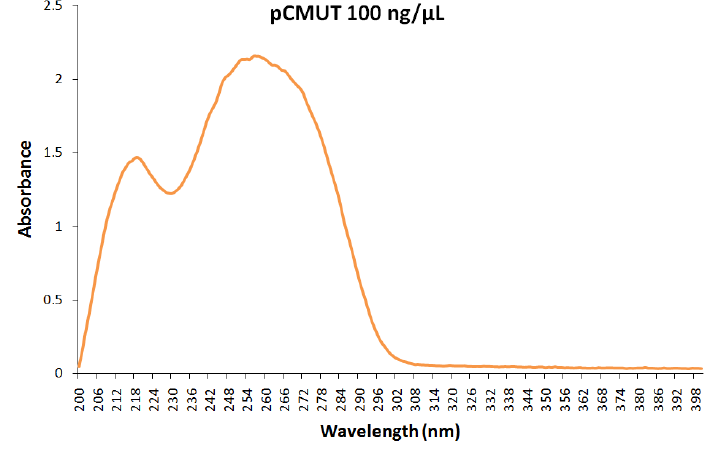
Figure 3. The absorption spectrum for the DNA molecule. A sample of purified plasmid DNA (pCMUT vector), diluted in a TE buffer (10 mM Tris-HCl [pH 8.0], 1 mM EDTA [pH 8.0]) at the indicated concentration, was used to obtain this spectrum, with an Evolution 300 UV-Vis Spectrophotometer (ThermoFisher Scientific,